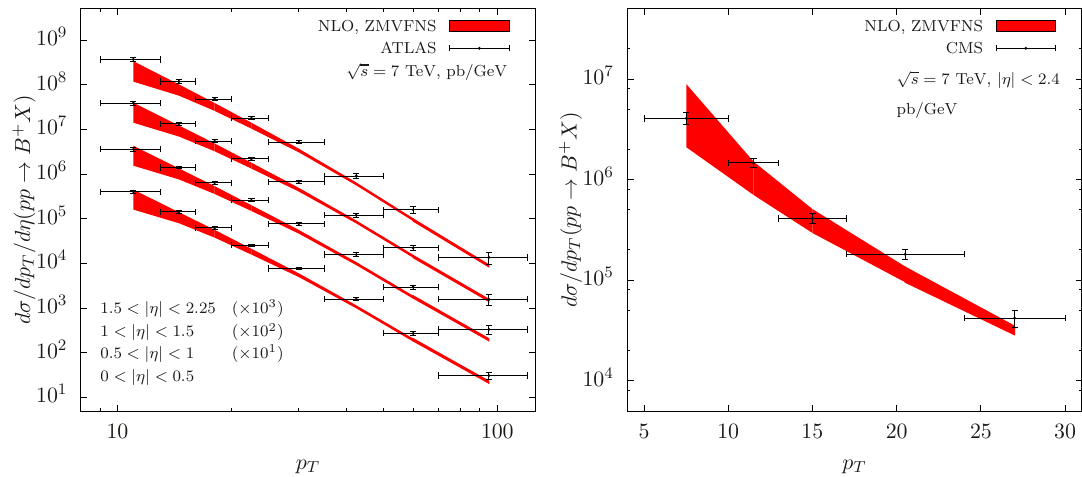
p s = 7 TeV within the ZM-VFNS [56, 93, p p 2 + m 2 . T b